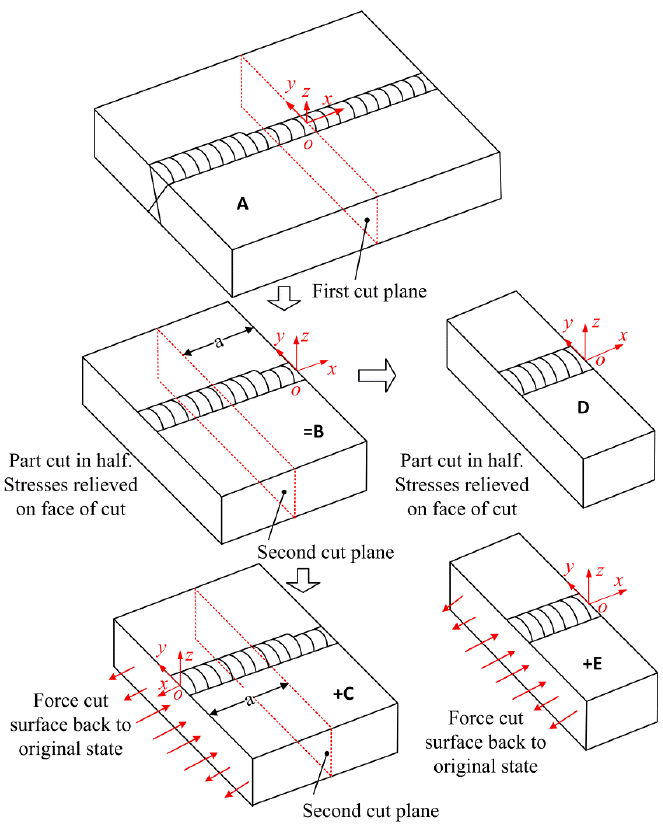
Figure 4. Superposition principle to reconstruct the original stresses on the plane of the second cut.